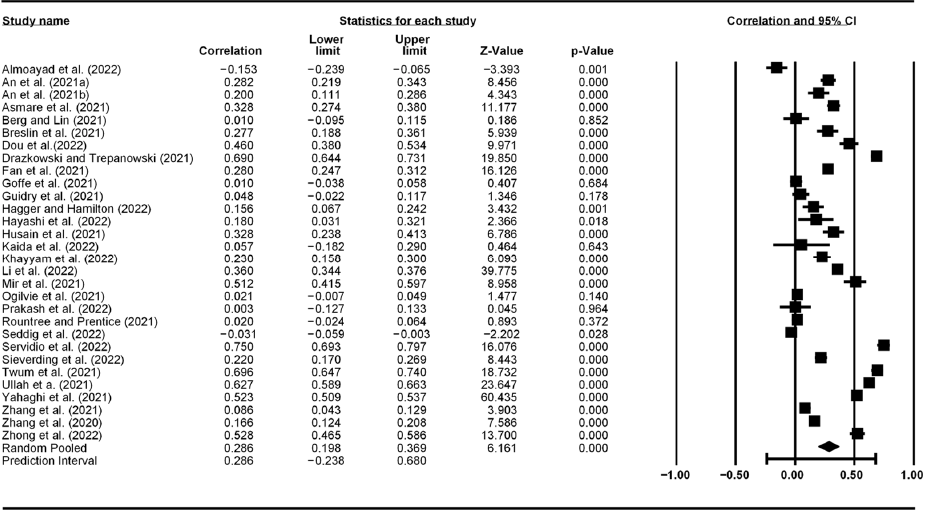
Figure 3. Forest plot showing subjective norms and vaccination intention correlation.